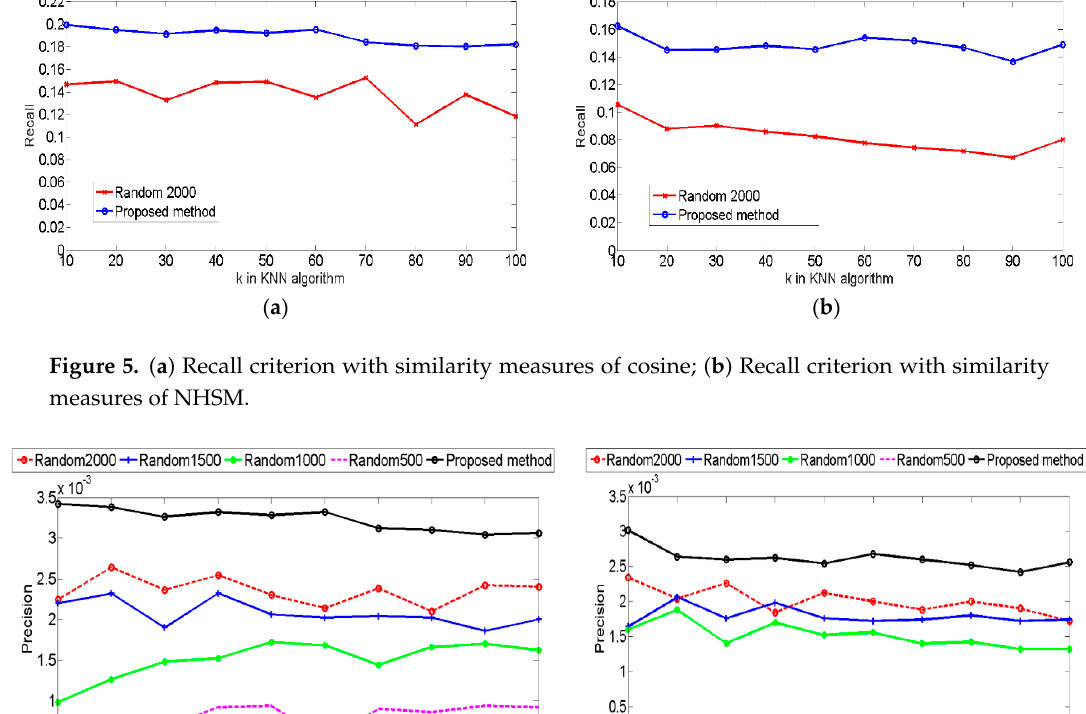
( b ) Figure 3. ( a ) Recall criterion with similarity measures of cosine; ( b ) Recall criterion with similarity measures of NHSM. ( b ) Figure 4. ( a ) Precision criterion with similarity measures of cosine; ( b ) Precision criterion with similarity measures of NHSM. In the final experiment, we consider the effect of items from (cid:1863) nearest users (step 3 of Figure 1b) together with favourite category of the cold users (step 5 of Figure 1b) and compare it with a traditional recommender system (Figure 1a). Figure 5 shows the recall criterion. It can be seen that the proposed method has higher recall